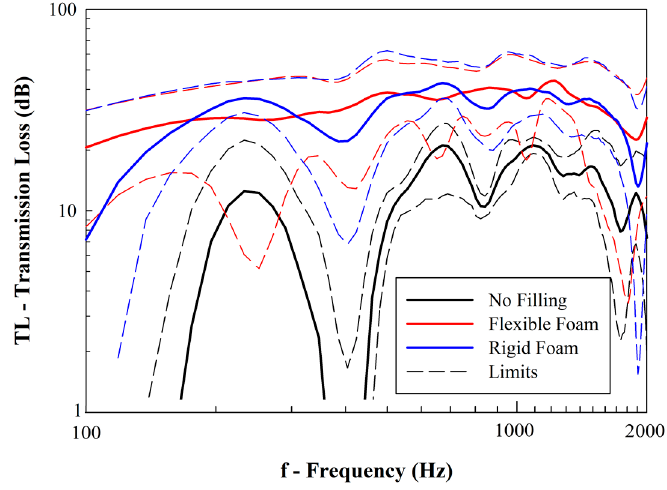
Figure 18. Results from acoustic transmission loss (solid and dashed lines represent, respectively, the average and maximum/minimum values).